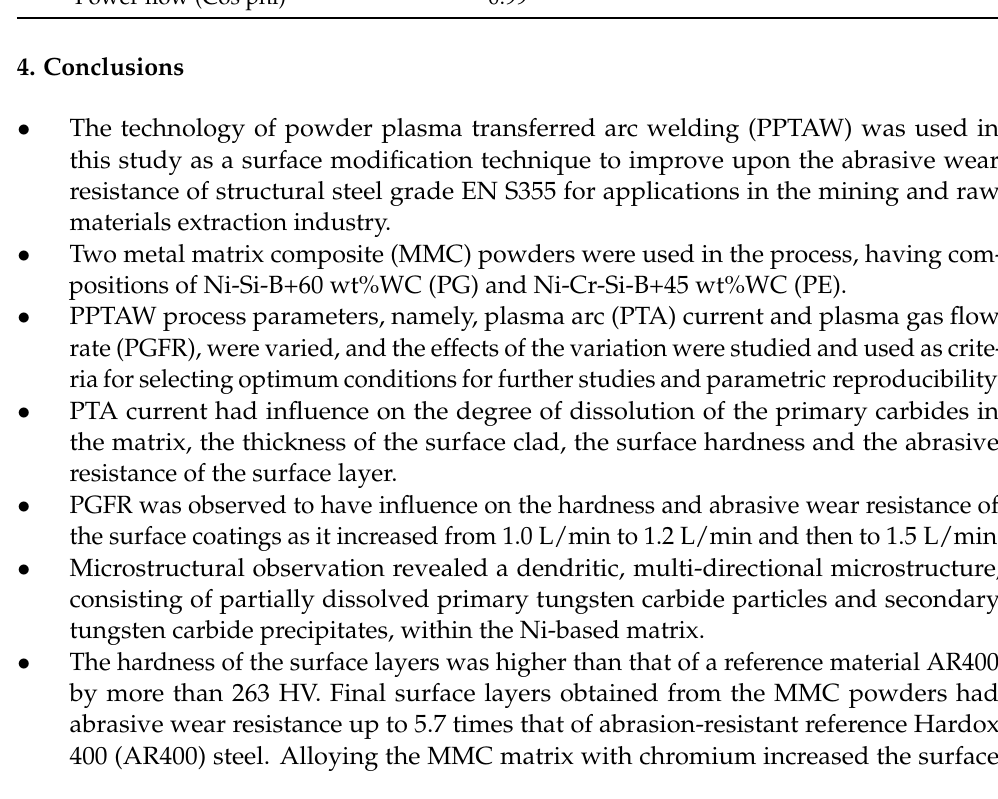
Table 10. Optimum process parameters used for sample preparation, applicable to the two MMC powders used for this study.